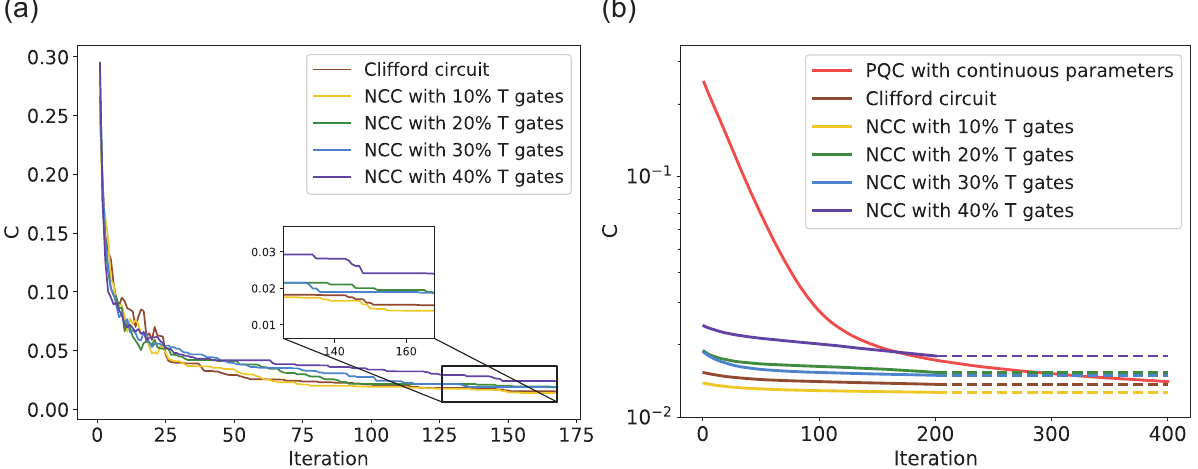
Figure 4. Simulation results of NCC-WS training for classification task on MNIST. ( a ) The average C during pretraining plotted as a function of iteration past the probability of T gate appearing in NCC used in warm start, for iterations from 1 to 168, and the probability ranging from 0 to 40% in steps of 10%. All curves eventually converge steadily around 0.02, where the yellow curve that has largest expressibility value has the minimum convergence value. ( b ) Comparison of the training effect of conventional VQA and NCC-WS VQA with settings in ( a ) for classification task, where the dashed lines are numerical extensions of the corresponding experimental results and do not represent the real training. We observe that there exists an obvious difference at the beginning of training, where NCC-WS VQA has noticeable smaller C value. However, the initial parameters superiority found by NCC-WS will not necessarily be retained, where the cost value of conventional VQA, i.e., the orange curve, is smaller than that of NCC-WS VQA with 20%, 30%, and 40% T gates, although it still has a slow decreasing trend after 400